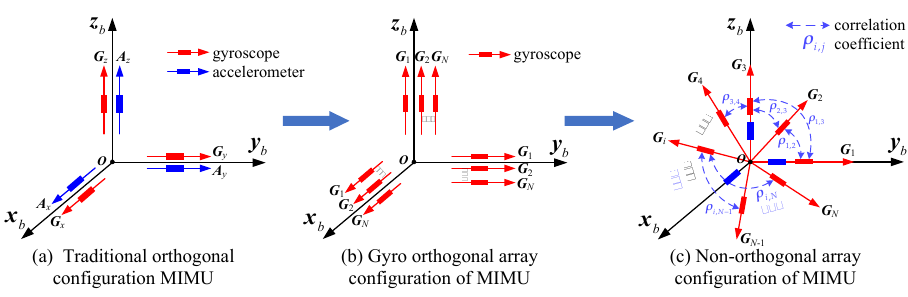
Figure 1. Schematic diagram of the MIMU formed by different MEMS inertial sensors.